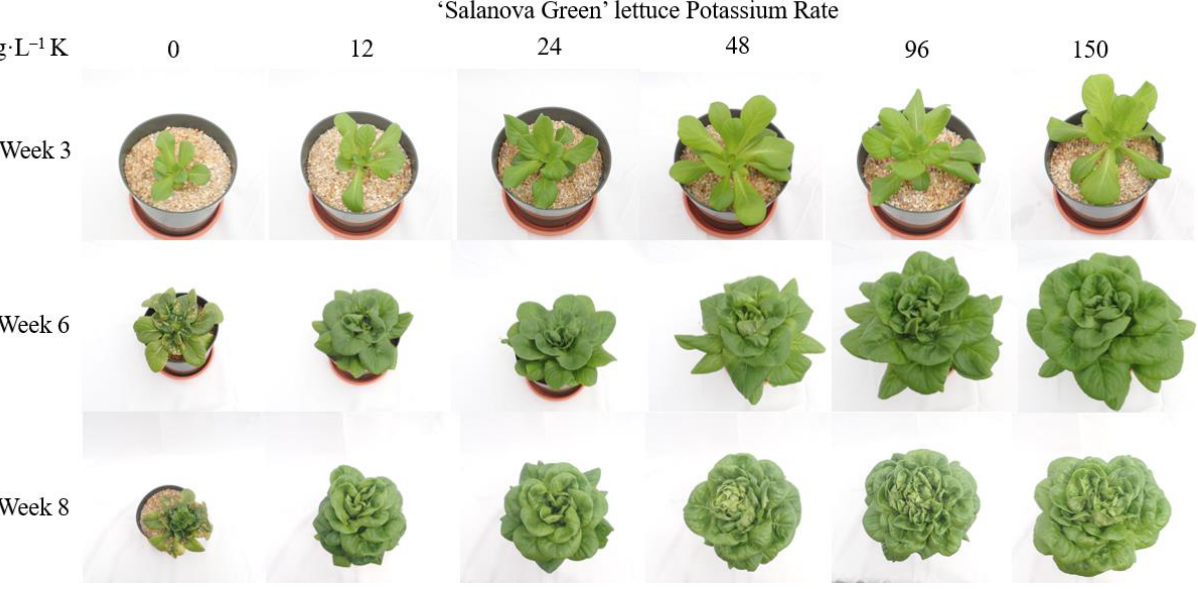
Figure 3. Visual impact of potassium (K) fertility rate on Lactuca sativa ‘Salanova Green’ at Weeks 3, 6, and 8.